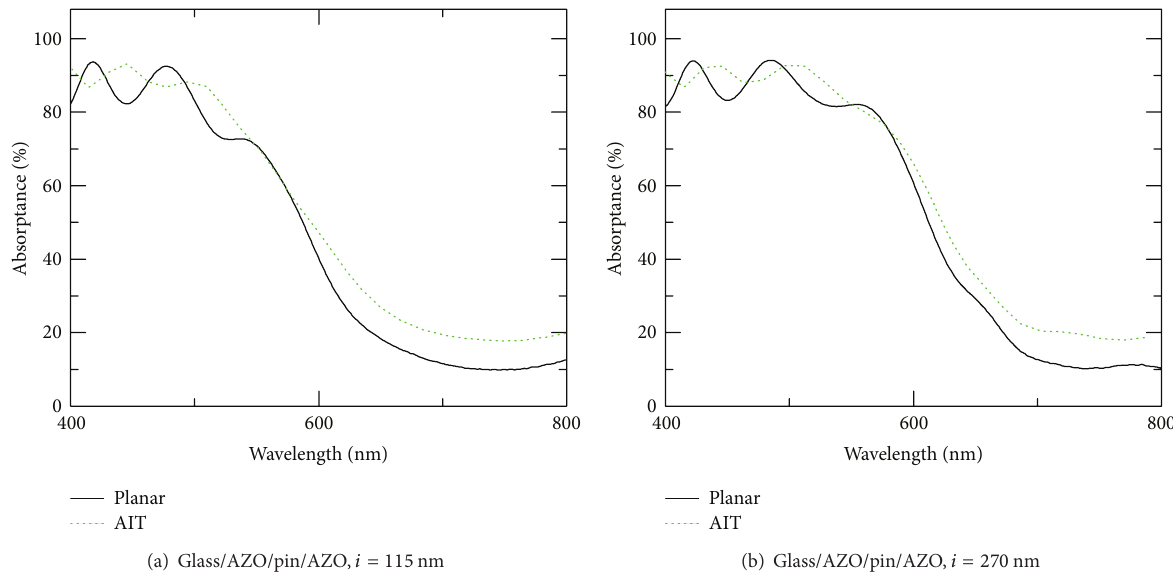
Figure 5: Measured absorptance of the a-Si:H solar cell precursors on AIT glass and planar glass. The intrinsic a-Si:H layer thickness is (a) 115nm and (b) 270 nm.